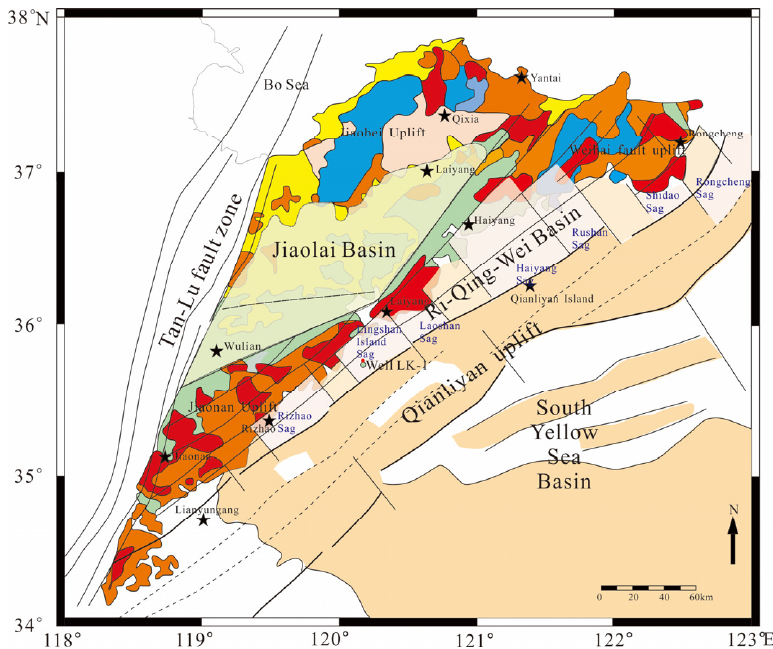
Figure 1. Geological map of the Ri-Qing-Wei Basin (Adapted with permission from Ref. [10]. 2021, Zhou, T.).